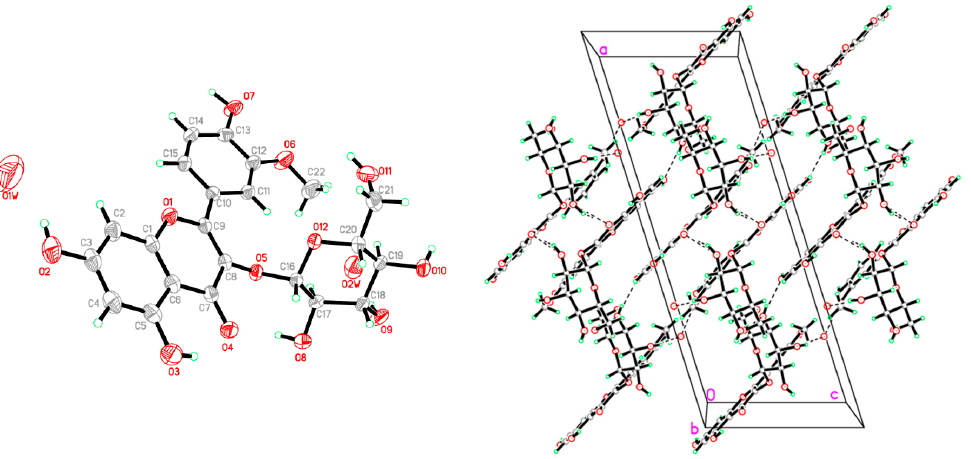
Figure 1. ORTEP diagram of IR3G. Displacement ellipsoids are plotted at the 40% probability level for non ‐ H atoms ( left ). Molecular packing of IR3G with viewed hydrogen bonds is drawn as dashed lines ( right ).